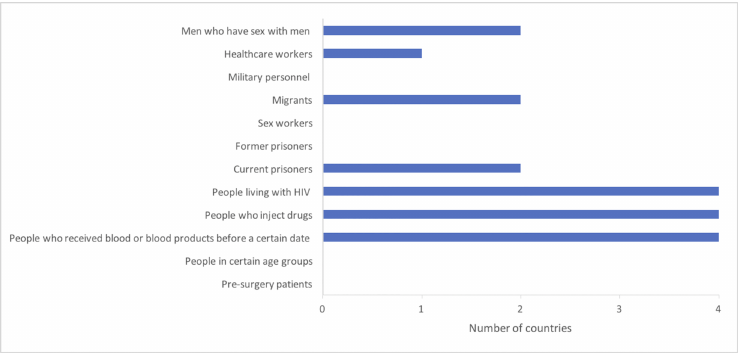
Fig 1. Groups that should be routinely offered HCV testing according to national